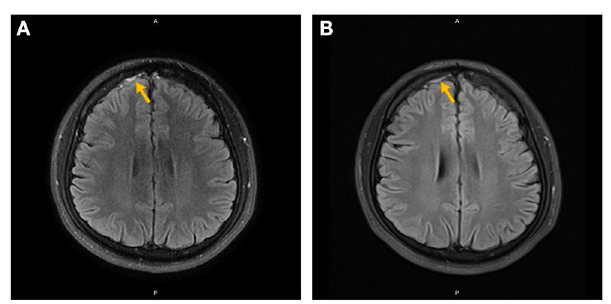
FIGURE 1 | Non-enhanced (A) and contrast-enhanced (B) MRI of the brain in Case 4. The orange arrow indicates subarachnoid hemorrhage in the right frontal lobe.